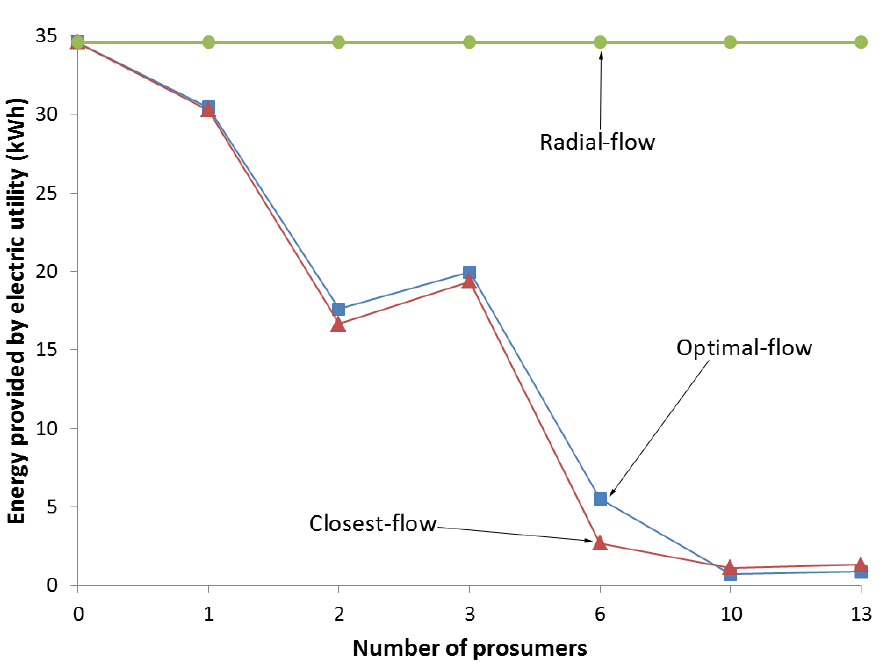
Figure 5. Energy provided by the electric